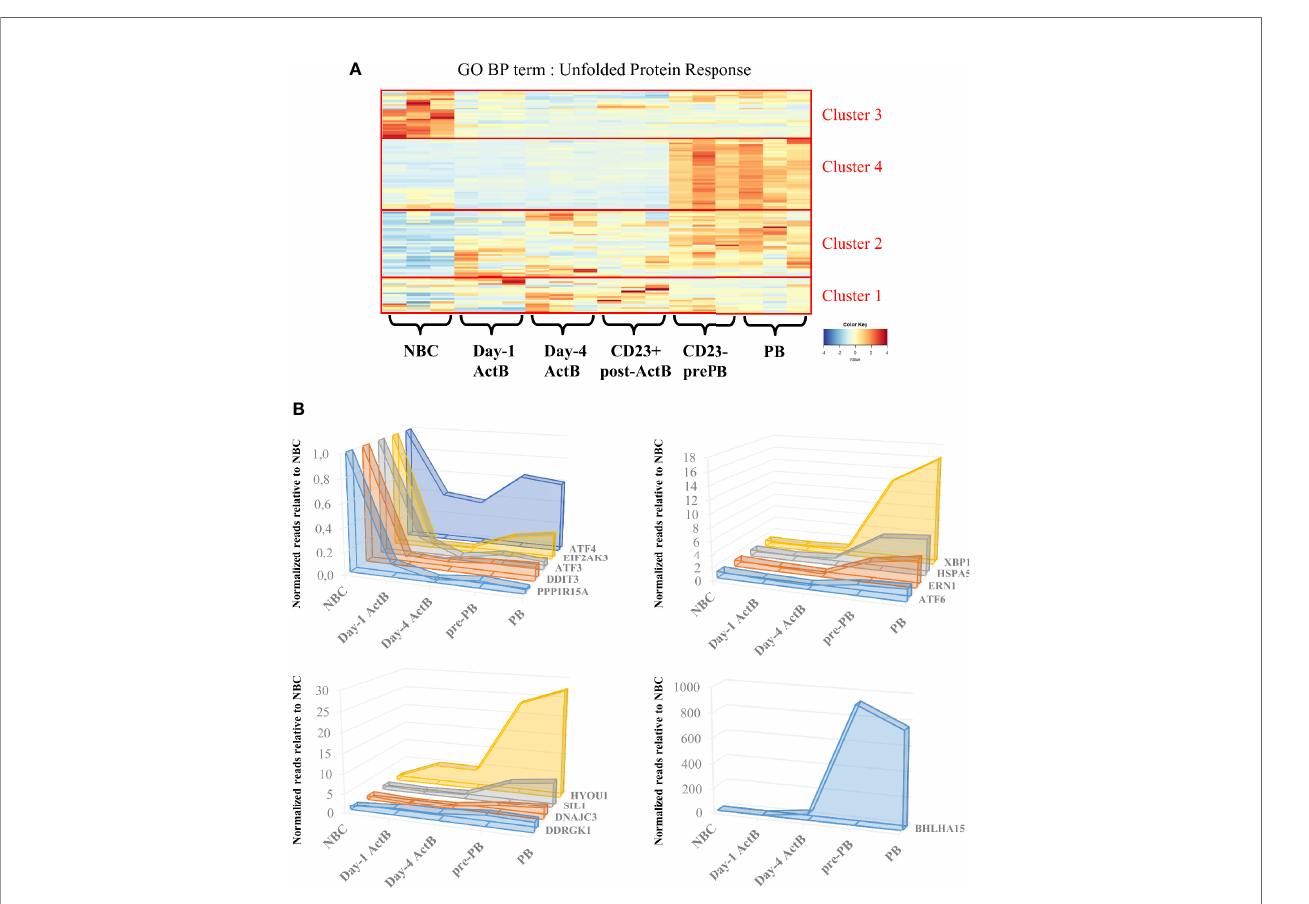
FIGURE 3 | Unfolded protein response is temporally regulated during the transition from naive B cells to plasmablasts. (A) Genes belonging to the Gene Ontology – Biological Processes term “ Unfolded Protein Response ” were selected and their expression in our RNA-seq data was submitted to an unsupervised hierarchical clustering analysis. The resulting heatmap is shown here, delineating four different expression clusters: (1) stable expression, (2) genes upregulated from Day-1, (3) genes upregulated in NBC and (4) genes upregulated in Pre-PB and PB. (B) Means of normalized reads obtained from 3 different experiments at Day-1 ActB, Day-4 ActB, pre-PB and PB stages were compared to the NBC counterpart, whose mean is reduced to 1. Left upper panel shows genes related to the PERK pathway. Right upper panel shows genes related to the IRE1 a and ATF6 pathways and lower panels show potential genes which are either implicated (i) in the PERK regulation or (ii) in endoplasmic reticulum modi fi cations related to stress. All of the selected genes are addressed in this